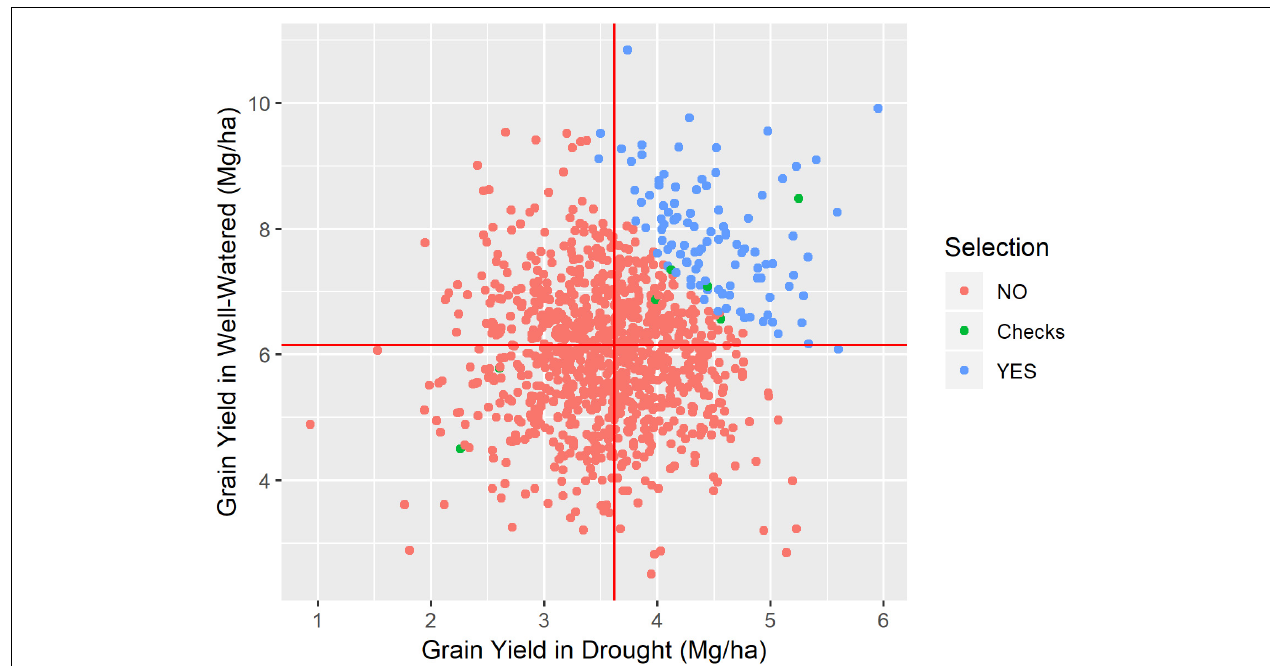
FIGURE 2 | Grain yield at drought condition against the grain yield at well-watered condition, for the Los Mochis trial, where 1067 genotypes were tested. Highlighted in blue the 104 highest drought-tolerant, simulating a 10% of selection intensity, the six checks used (green) and the 956 not selected by the simulated selection